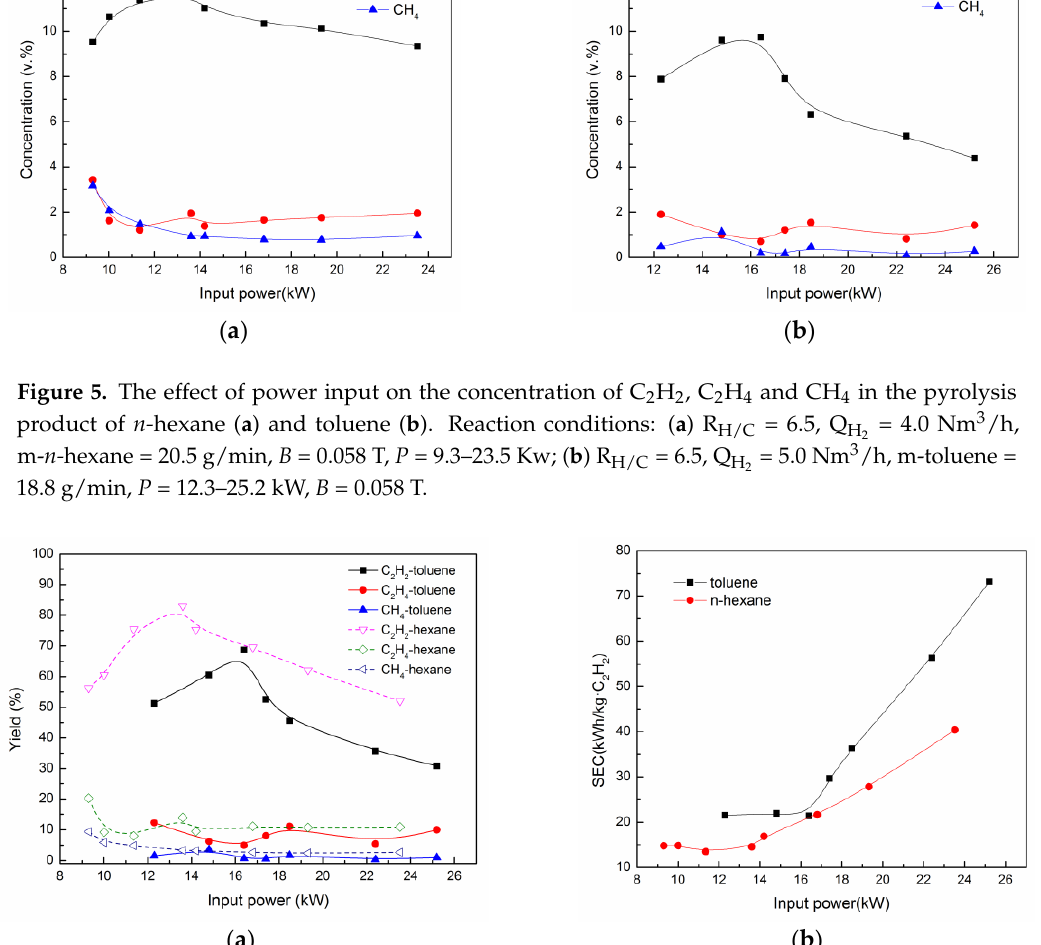
Figure 6. The effect of power input on the yield ( a ) and specific energy consumption (SEC) ( b ) of C 2 H 2 . Reaction conditions: ( a ) R H/C = 6.5, Q = 4.0 Nm 3 /h, m- n- hexane = 20.5 g/min, B = 0.058 T, P = 9.3–23.5 kW; ( b ) R H/C = 6.5, Q = 5.0 Nm 3 /h, m-toluene = 18.8 g/min, P = 12.3–25.2 kW, B = 0.058 T.